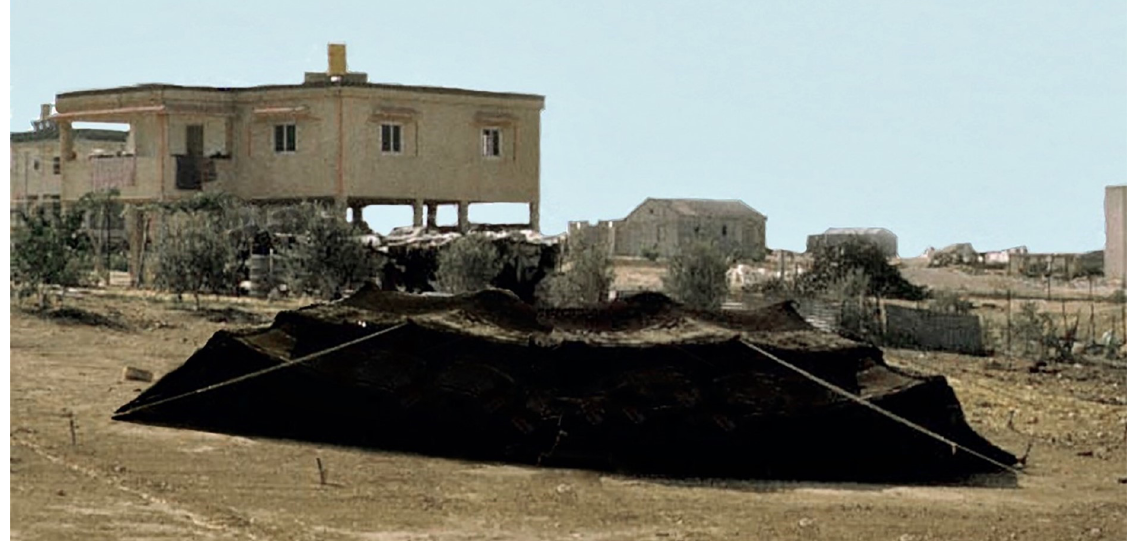
Figure 1 Rahat, north of Be’er Sheva‘, 1976: a Bedouin tent for the elders is pitched next to their children’s house (photograph by Orna